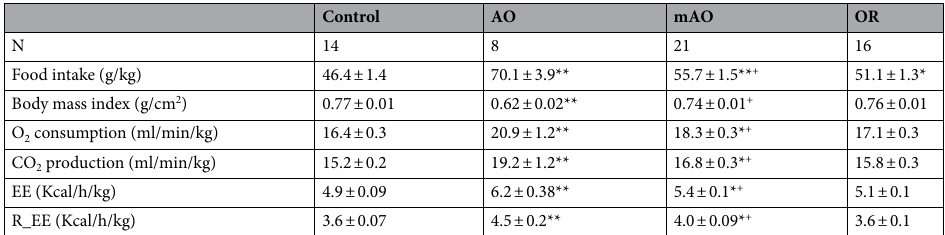
Table 2. Energy metabolism at week 10. Values are mean ± SEM over 24 h. Statistical differences were determined by a one-way analysis of variance. EE energy expenditure, R_EE resting energy expenditure, AO obstructive, mAO mild obstruction, OR obstruction removal. * p < 0.05, ** p < 0.01—C vs. AO, mAO or + p < 0.05 mAO vs. AO.